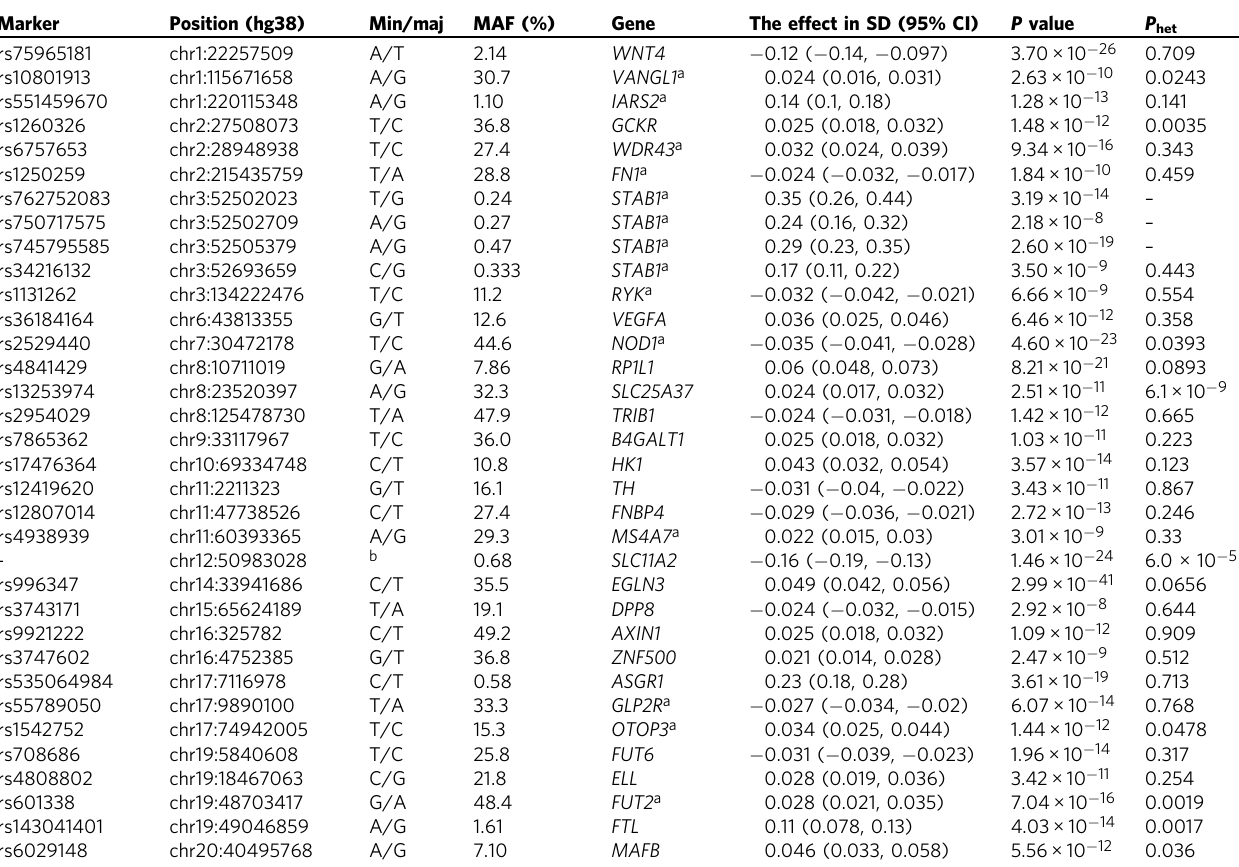
Table. 2 Novel ferritin-associated variants found in the meta-analysis of Icelandic, UK, and Danish data, excluding variants that also associate with other iron homeostasis biomarkers (iron, TIBC, and TSAT).